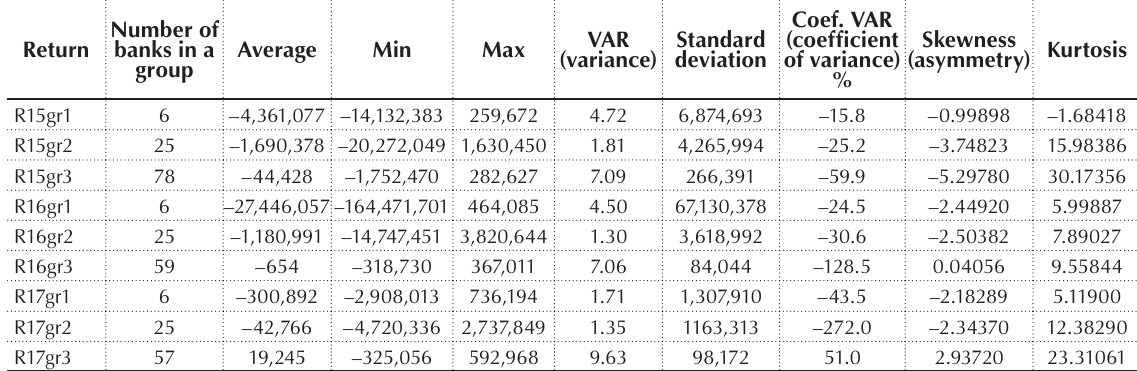
Table 4. (cid:115)(cid:258)(cid:396)(cid:349)(cid:258)(cid:374)(cid:272)(cid:286)(cid:400)(cid:3)(cid:381)(cid:296)(cid:3)(cid:396)(cid:286)(cid:410)(cid:437)(cid:396)(cid:374)(cid:400)(cid:876)(cid:367)(cid:381)(cid:400)(cid:400)(cid:286)(cid:400)(cid:3)(cid:381)(cid:296)(cid:3)(cid:104)(cid:364)(cid:396)(cid:258)(cid:349)(cid:374)(cid:349)(cid:258)(cid:374)(cid:3)(cid:271)(cid:258)(cid:374)(cid:364)(cid:400)(cid:3)((cid:271)(cid:258)(cid:400)(cid:286)(cid:282)(cid:3)(cid:381)(cid:374)(cid:3)(cid:336)(cid:396)(cid:381)(cid:437)(cid:393)(cid:400)(cid:3)(cid:258)(cid:272)(cid:272)(cid:381)(cid:396)(cid:282)(cid:349)(cid:374)(cid:336)(cid:3)(cid:410)(cid:381)(cid:3)(cid:69)(cid:17)(cid:104)(cid:3) (cid:272)(cid:367)(cid:258)(cid:400)(cid:400)(cid:349)(cid:302)(cid:272)(cid:258)(cid:415)(cid:381)(cid:374)(cid:895)(cid:3)(cid:282)(cid:437)(cid:396)(cid:349)(cid:374)(cid:336)(cid:3)(cid:410)(cid:346)(cid:286)(cid:3)(cid:455)(cid:286)(cid:258)(cid:396)(cid:400)(cid:3)(cid:1006)(cid:1004)(cid:1005)(cid:1009)(cid:884)(cid:1006)(cid:1004)(cid:1005)(cid:1011) (cid:3) (cid:94)(cid:381)(cid:437)(cid:396)(cid:272)(cid:286)(cid:855)(cid:3)(cid:705)(cid:258)(cid:367)(cid:272)(cid:437)(cid:367)(cid:258)(cid:410)(cid:286)(cid:282)(cid:3)(cid:271)(cid:455)(cid:3)(cid:410)(cid:346)(cid:286)(cid:3)(cid:258)(cid:437)(cid:410)(cid:346)(cid:381)(cid:396)(cid:400)(cid:3)(cid:271)(cid:258)(cid:400)(cid:286)(cid:282)(cid:3)(cid:381)(cid:374)(cid:3)(cid:69)(cid:17)(cid:104)(cid:3)(cid:282)(cid:258)(cid:410)(cid:258)(cid:3)(cid:449)(cid:349)(cid:410)(cid:346)(cid:3)(cid:410)(cid:346)(cid:286)(cid:3)(cid:346)(cid:286)(cid:367)(cid:393)(cid:3)(cid:381)(cid:296)(cid:3)(cid:400)(cid:381)(cid:296)(cid:410)(cid:449)(cid:258)(cid:396)(cid:286)(cid:3)(cid:94)(cid:410)(cid:258)(cid:415)(cid:400)(cid:415)(cid:272)(cid:258)(cid:3)(cid:1005)(cid:1004)(cid:856)(cid:1004)(cid:856)(cid:3)((cid:286)(cid:454)(cid:272)(cid:367)(cid:437)(cid:282)(cid:349)(cid:374)(cid:336)(cid:3)(cid:349)(cid:374)(cid:400)(cid:381)(cid:367)(cid:448)(cid:286)(cid:374)(cid:410)(cid:3)(cid:271)(cid:258)(cid:374)(cid:364)(cid:400)(cid:895)(cid:856)